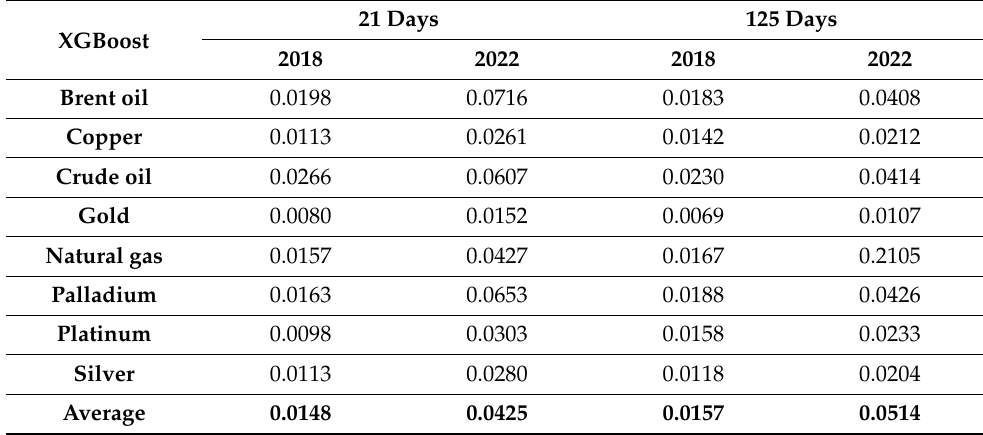
Table 12. Extreme Gradient Boost (XGBoost) forecast